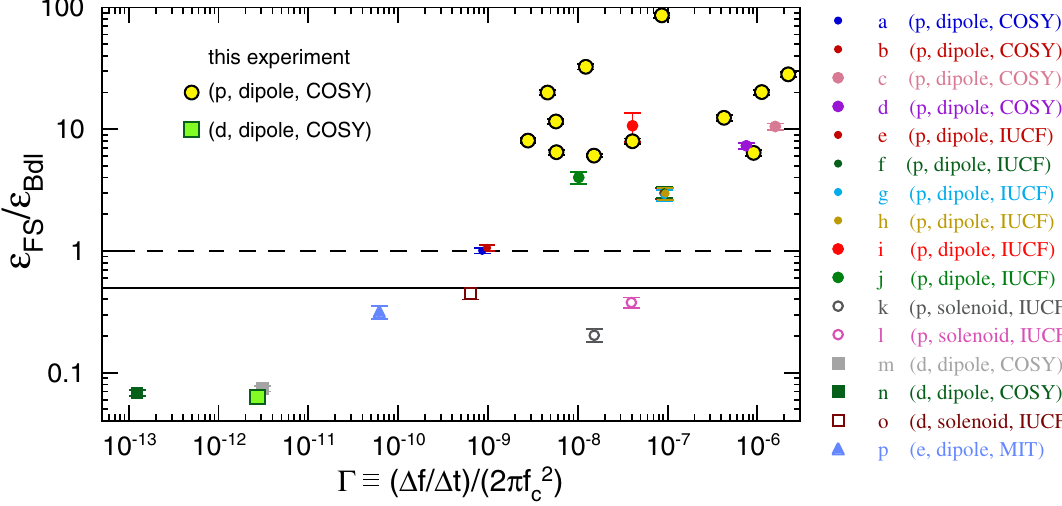
FIG. 8. (Color) Ratio of E to E is plotted vs the dimensionless crossing rate (cid:2) giving P (cid:1) 0 in each (cid:1) t curve [31]. E FS Bdl resonance strength obtained by fitting the data in each (cid:1) t curve to Eq. (3); E (5). The dashed and solid lines show the ratios predicted by [26–28] and [29,30], respectively. Note that points (a) and (b) overlap, as do points (e)–(h). The data for all points are listed in Table